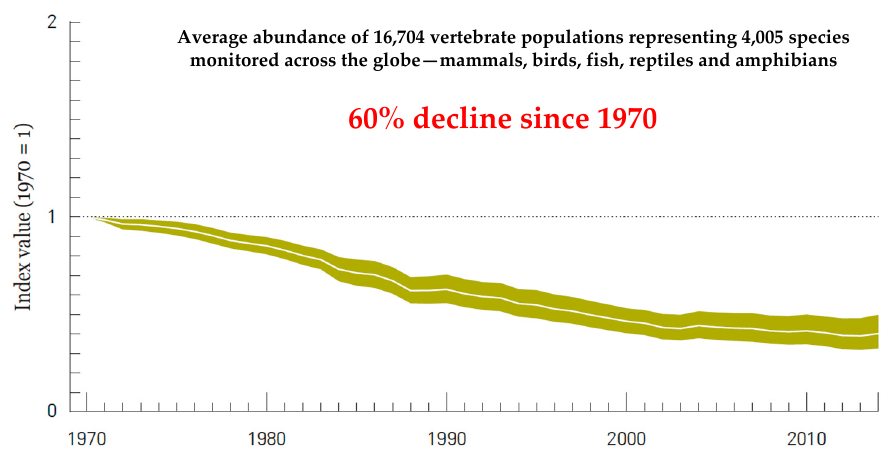
Figure 3. The Living Planet Index. Source: WWF—World Wide Fund for Nature (2018) Living Planet Report—2018: Aiming Higher, © 2018 WWF—All rights reserved.